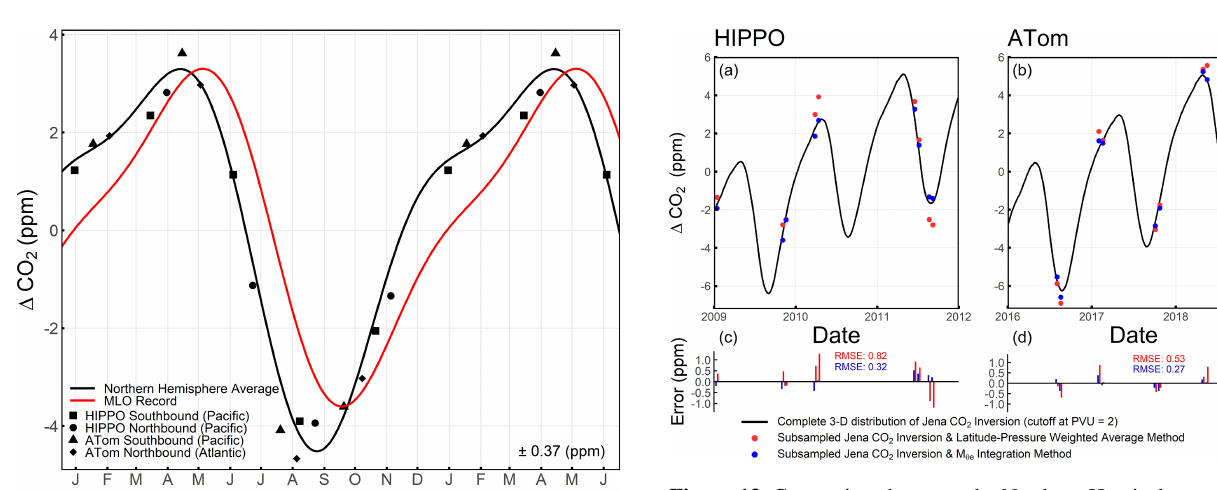
Figure 13. Comparison between the Northern Hemisphere average CO 2 from full integration of the simulated atmospheric fields from Figure 12. Comparison between the CO 2 seasonal cycle of North- the Jena CO 2 inversion (cutoff at PVU = 2) and from two methods ern Hemisphere tropospheric average computed from airborne ob- that use the same simulated data subsampled with HIPPO or ATom servation and the M θ integration method (black points and line) coverage: (1) the M θ integration method (blue) and (2) simple in- e e and the mean cycle at MLO measured by Scripps CO 2 Program tegration by sin(latitude)–pressure (red). We divide the comparison from 2009 to 2018 (red line). Both are detrended by subtracting a into HIPPO (a, c) and ATom (b, d) temporal coverage. Panels (c) stiff cubic spline trend at MLO. We then compute mass-weighted and (d) shows the error for individual tracks using alternate sub- average detrended CO 2 for each airborne campaign transect, shown sampling as black points, with campaigns and transects presented as different shapes. The seasonal cycle of both are computed by a two-harmonic fit to the detrended time series. The 1 σ variability in the detrended average CO 2 values about the fit line is shown on the lower right. The first half year is repeated for clarity.